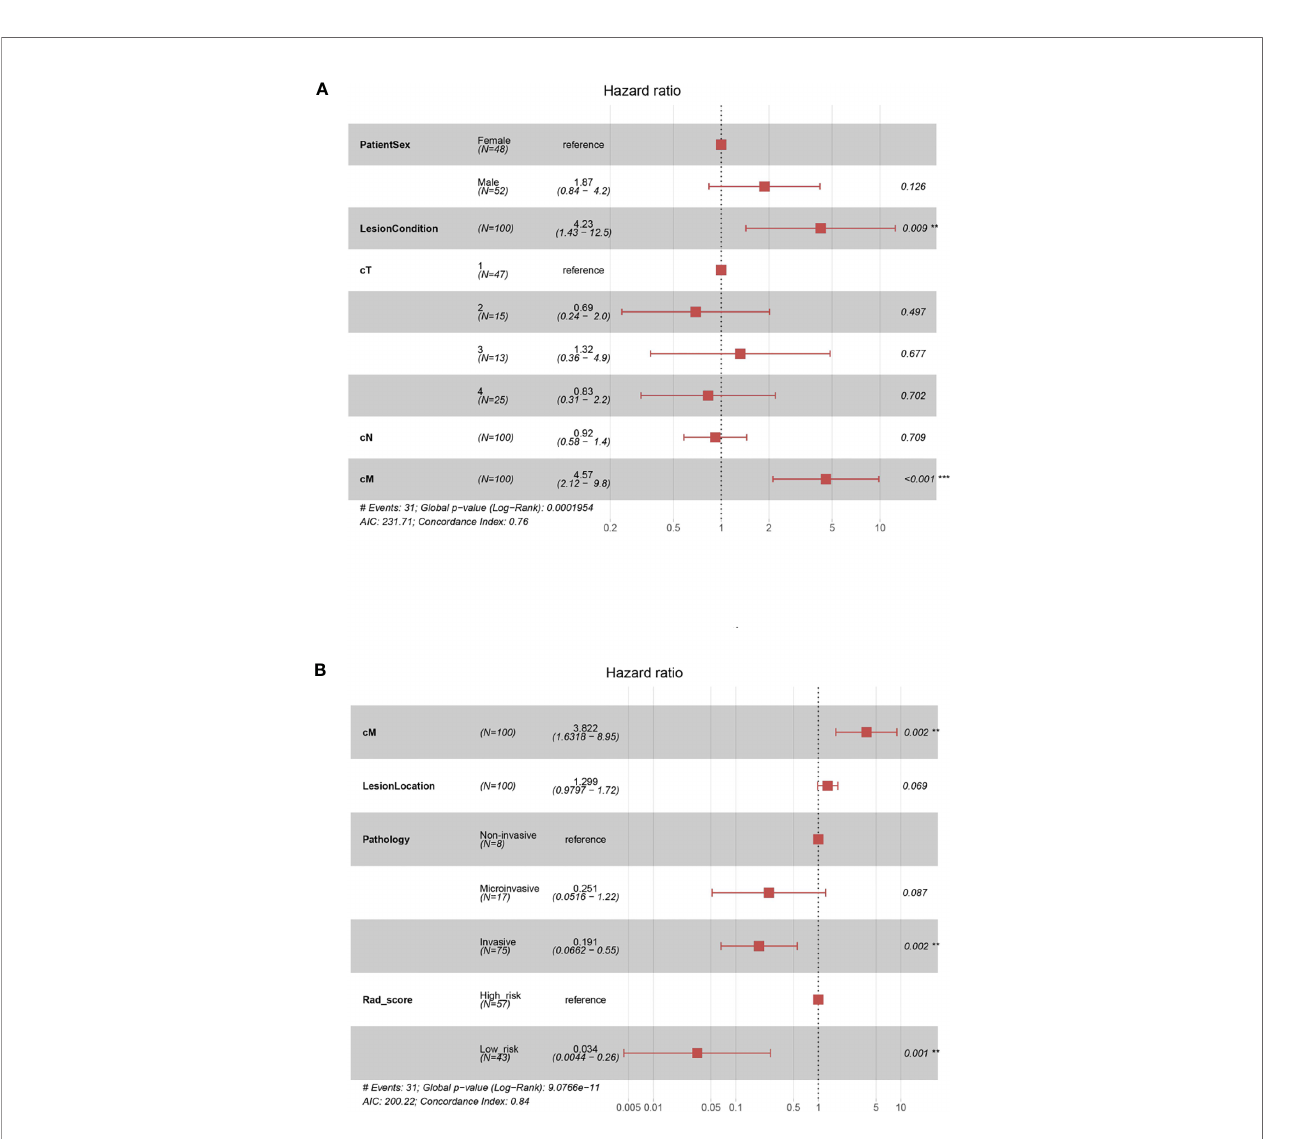
FIGURE 4 | (A) Forest plots of C-model. The forest plots of hazard ratio of each selected clinical factor in C-model, established from the training cohort. The likelihood ratio test was used to calculate P-value. (B) Forest plots of Combi-model. The forest plots showed each selected clinical factor ’ s hazard ratio in the combined model, established from the training